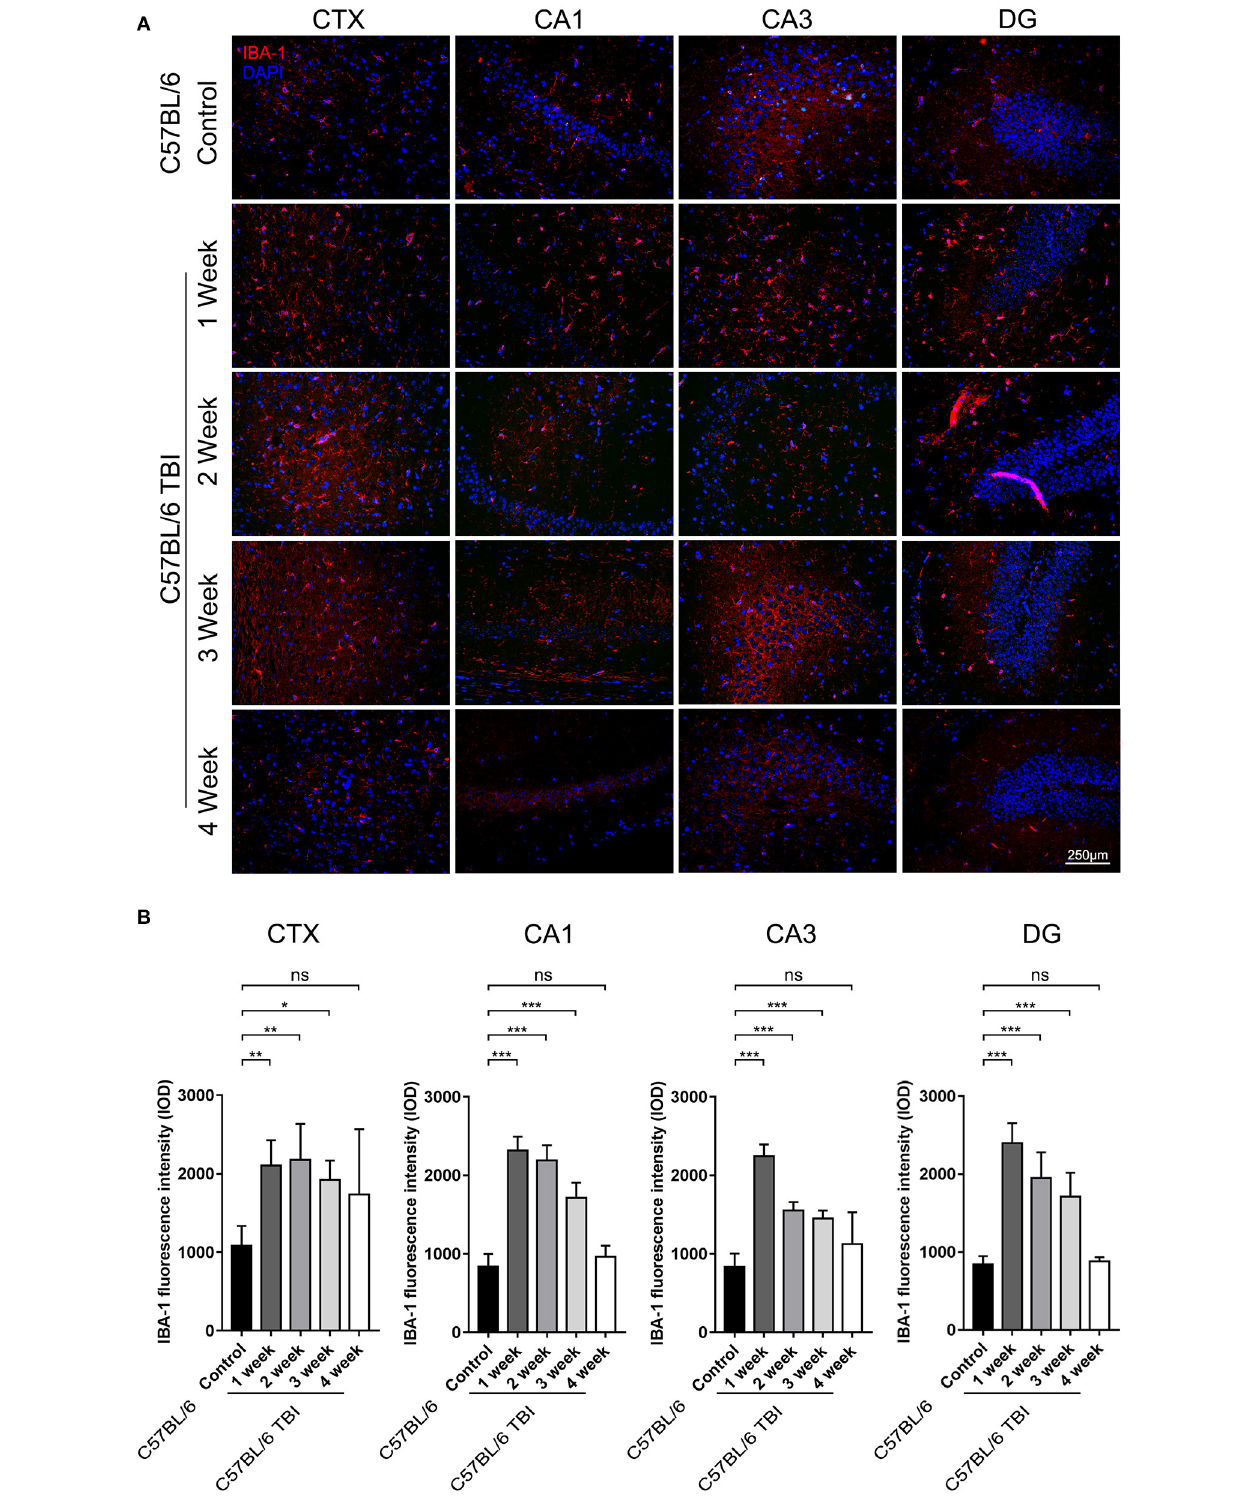
FIGURE 4 | TBI led to long-term activation of microglia in the brain. (A) Representative fluorescence images of cortical and hippocampal (CA1, CA3, and DG) tissues from C57BL/6 and C57BL/6 TBI group mice immunostained for IBA-1 (in red) and subjected to nuclear staining with DAPI (in blue). (B) The fluorescence intensity of IBA-1 in the cortex and in the hippocampus (CA1, CA3, and DG). The error bars represent the SEM ( n = 8/group). ns, non-significant; * p < 0.05; ** p < 0.01; *** p < 0.001.